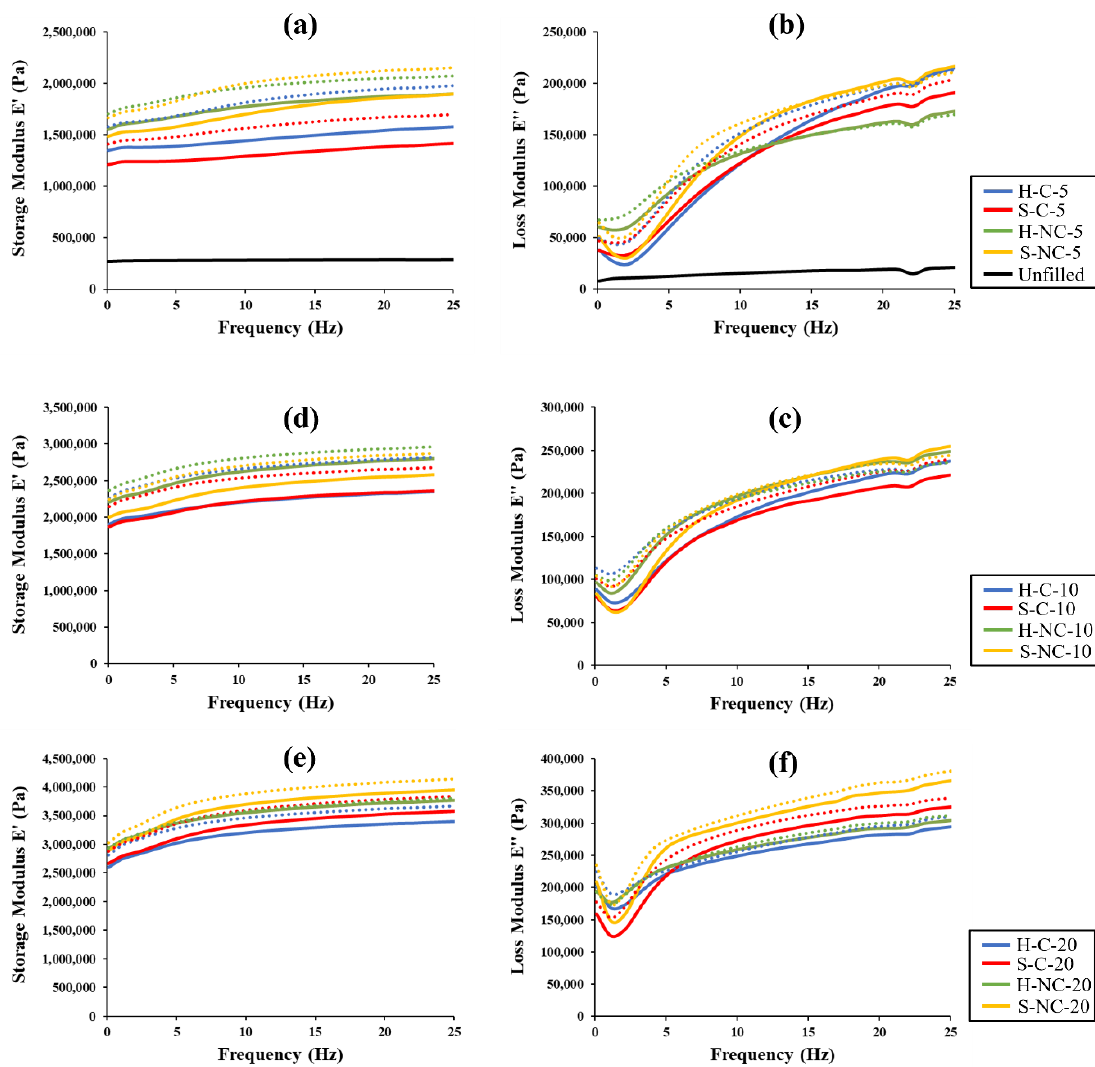
Figure 7. Frequency dependence of storage E’ and loss E’’ modulus measured in the off-state (solid lines) and on-state (dotted lines); ( a ) and ( b ): at 5%; ( c ) and ( d ) at 10%; ( e ) and ( f ) at 20% volume fractions.